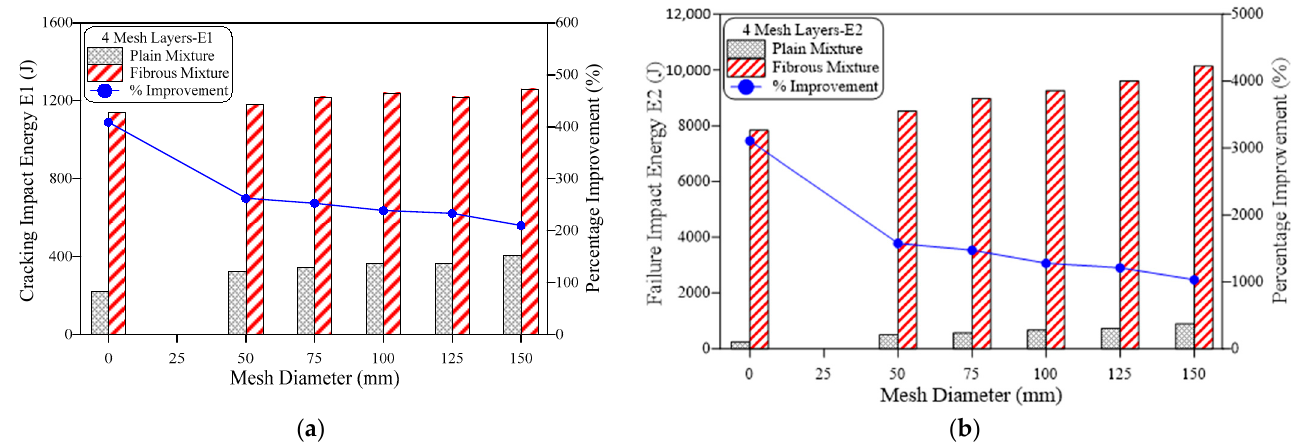
Figure 11. Effect of fiber on the impact energy of mixtures with 4-mesh layers, ( a ) cracking energy E1, ( b ) failure energy E2.